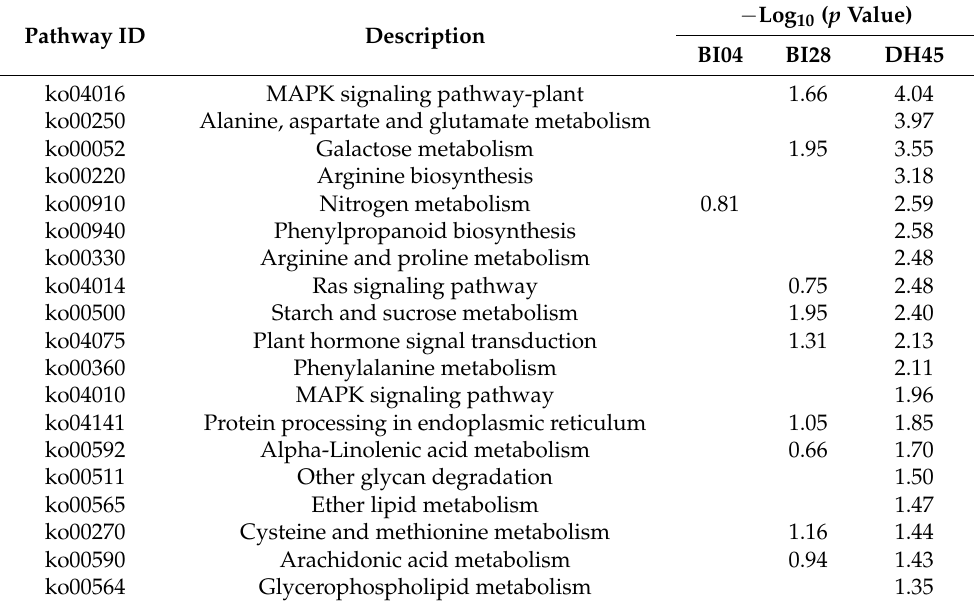
Table 5. Metabolic pathways of KEGG enrichment for selected 1027 DEG HP in DH45 relative to the